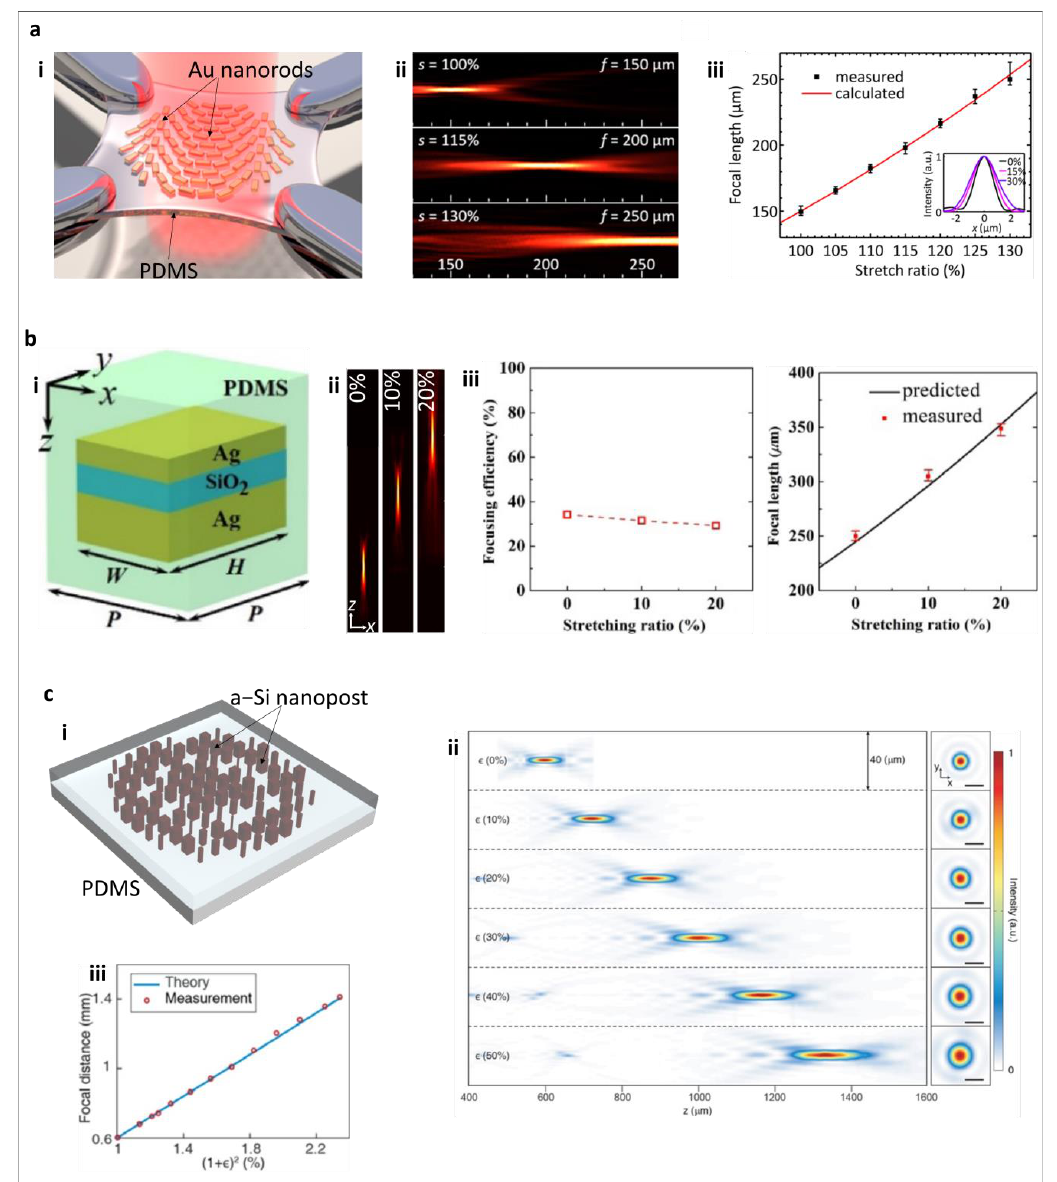
Figure 4. Mechanical tuning of metalenses . ( ai ) Illustration of a tunable metasurface based on a stretched deformable substrate (PDMS). ( aii ) Measured beam profile of the experimentally realized flat zoom lens based on ( ai ) with different stretch ratios, s . (top) Depicts a zoom lens with s = 100%; ( center ) depicts a zoom lens with s = 115%; and ( bottom ) depicts a zoom lens with s = 130%. ( aiii ) Depicts the measured (black dots) and calculated (red line) focal length of the flat zoom lens under different stretch ratios, s . ( bi ) Illustration of the metasurface unit cell. The silver–silica–silica (Ag–Si–Ag) composite meta- atom is encapsulated in PDMS. ( bii ) Measured beam profile of the experimentally realized metamirror depicting different focal lengths under stretch ratios of 0% ( top ), 10% ( middle ), and 20% ( bottom ). ( biii ) Depicts the measured and calculated focal length ( right ) and focusing efficiency ( left ) of the metamirror under different stretch ratios. ( ci ) Illustration of a metasurface based on silicon nanoposts encapsulated in PDMS. ( cii ) Depicts the measured beam profiles of the lens under radial strains (0–50%) in the axial plane ( left ) and focal plane ( right ). ( ciii ) Depicts the measured–calculated focal length of the lens as function of stretch ratios. Upon stretching, the focal length changes from 600 [ µ m] to 1400 [ µ m]. ( a ) Reprinted with permission from ref. [20]. Copyright (2016) American Chemical Society. ( b ) Reprinted under the Creative Commons Attribution 4.0 License (CC BY 4.0) from ref. [96]. ( c ) Reprinted with permission from ref. [95]. Copyright (2016) Wiley & Sons,